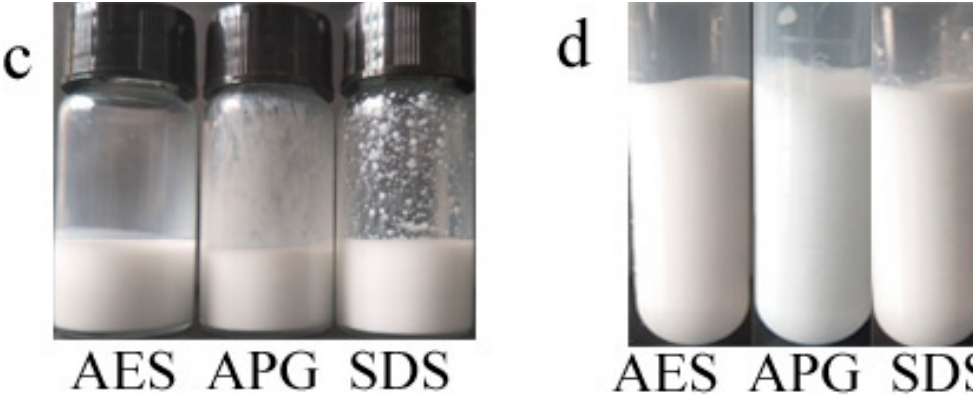
Figure 1. Stability of the emulsions, a : stored at room temperature; b : stored at 40 °C for 24 h; c : stored at − 10– − 15 °C; d : centrifugal stability.